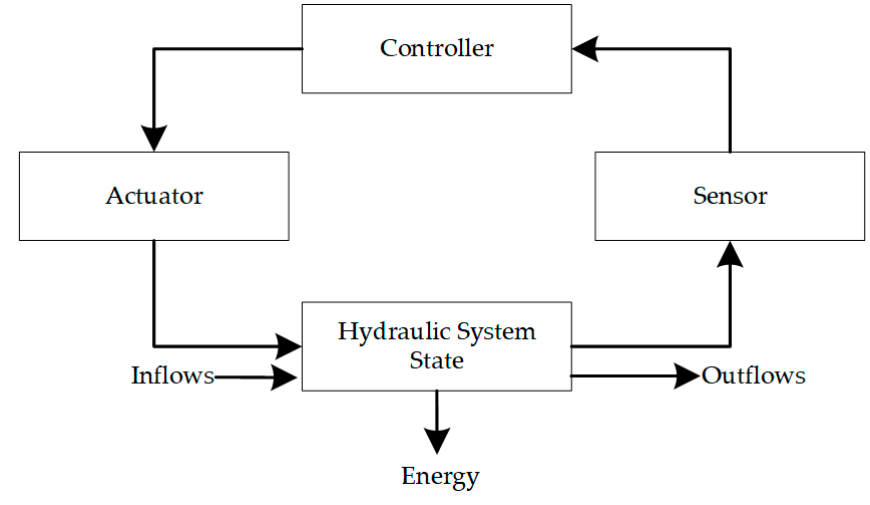
Figure 10. Generic control loop structure (after Leveson [20]).